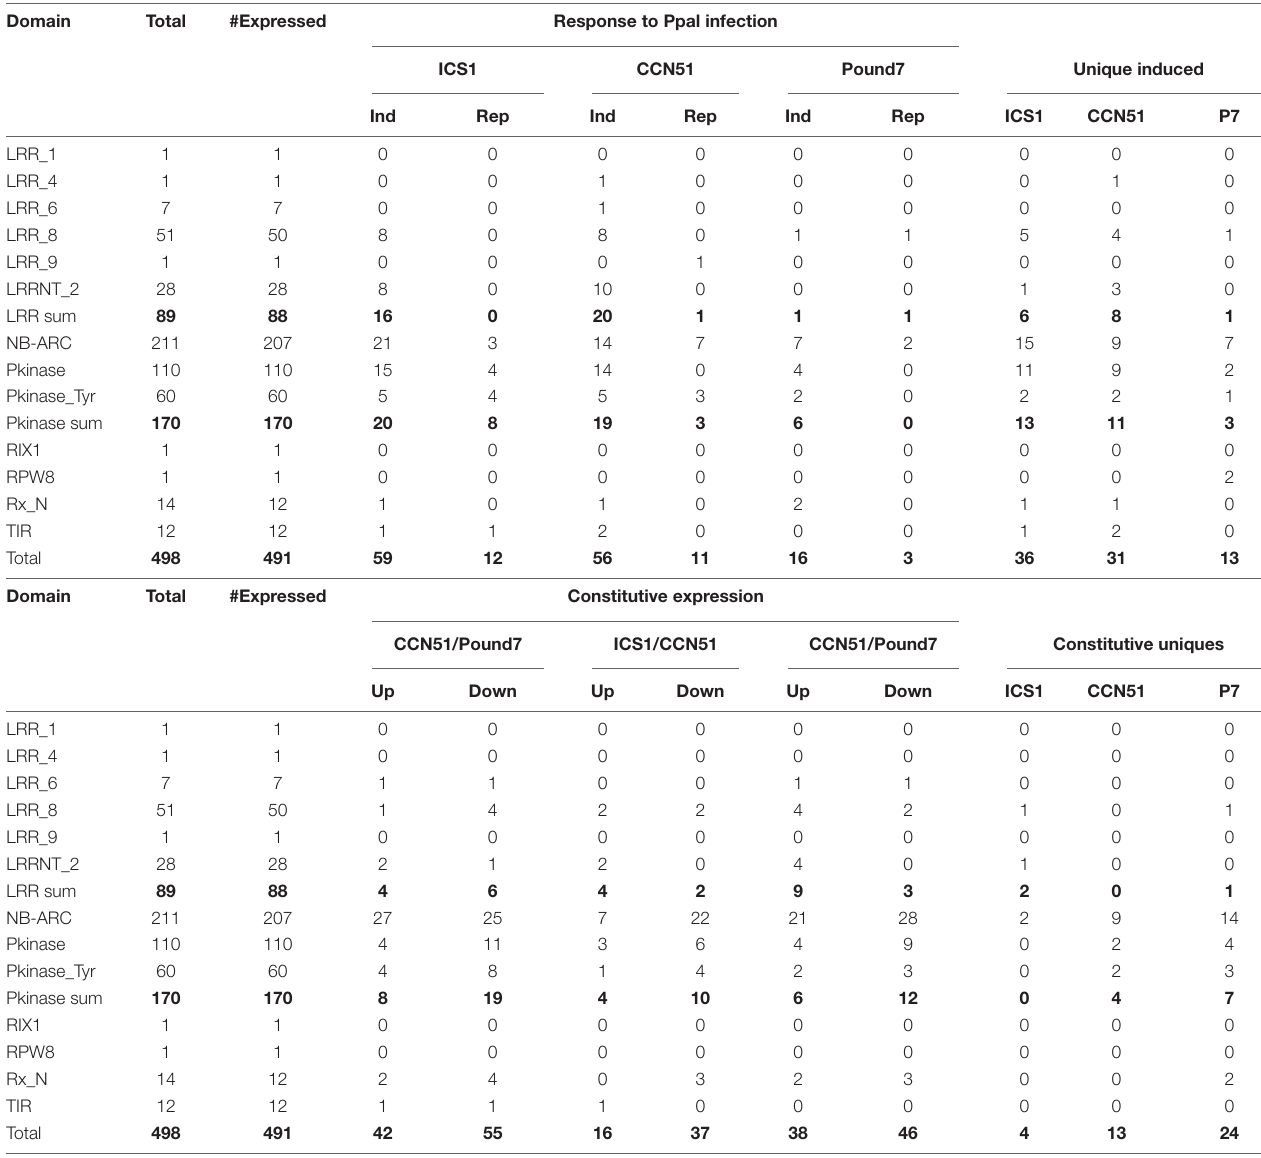
1 #Exp indicates a number of genes with at least 1 read. Ind and Rep indicate the number of genes induced or repressed by Ppal inoculation, respectively. Up and down indicate the number of genes with more/less constitutive expression in specific genotype comparisons, respectively. Constitutive uniques indicate the number of genes constitutively expressed at higher levels in the specific genotype